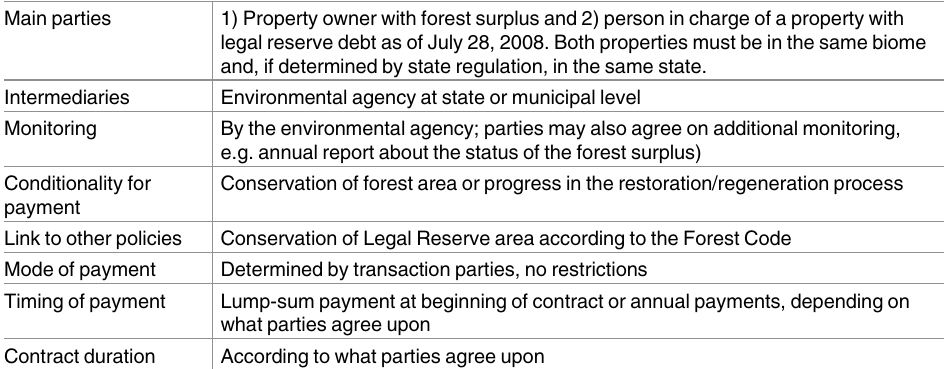
Table 1. Characteristics of the CRA based on